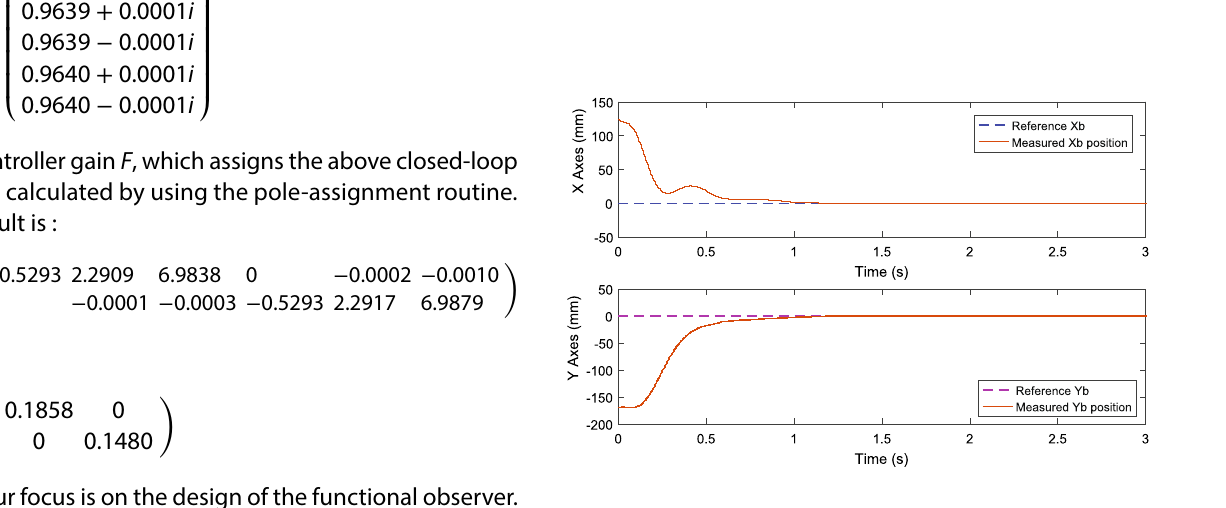
Fig. 7 The system’s experimental results are shown in Figure 7 and 8. Real-time and reference signals of the state feedback controller using the linear functional